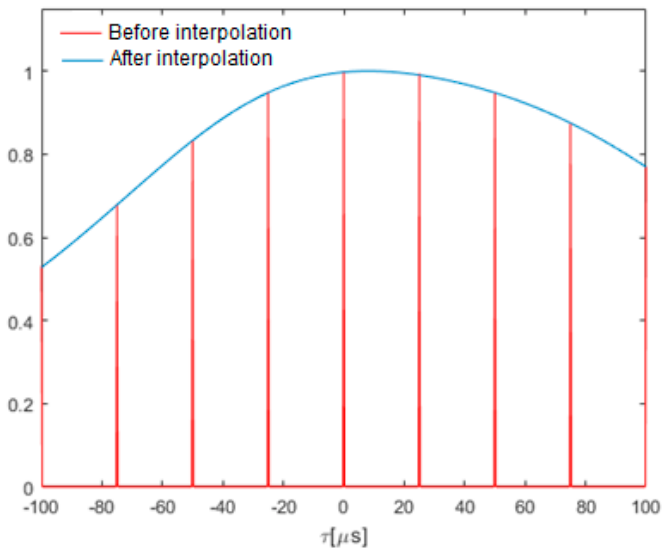
Figure 16. Comparison of the generalized correlation function before and after interpolation.